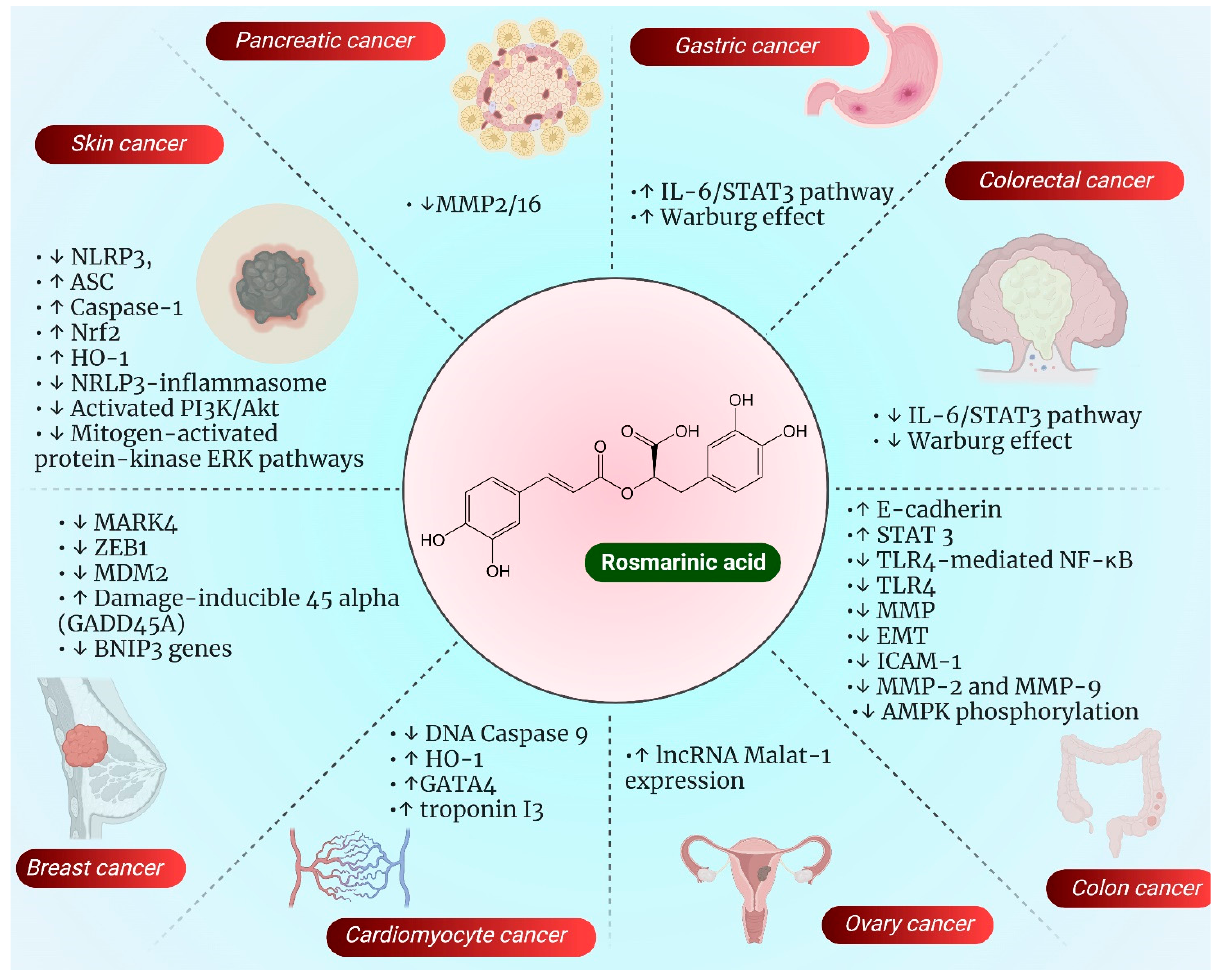
Figure 5. Figure depicting pharmacological action of rosmarinic acid on various molecular targets leading to different types of cancer based on the studies performed on various cancer cell lines. ↑ indicates upregulation and symbol ↓ indicates downregulation.